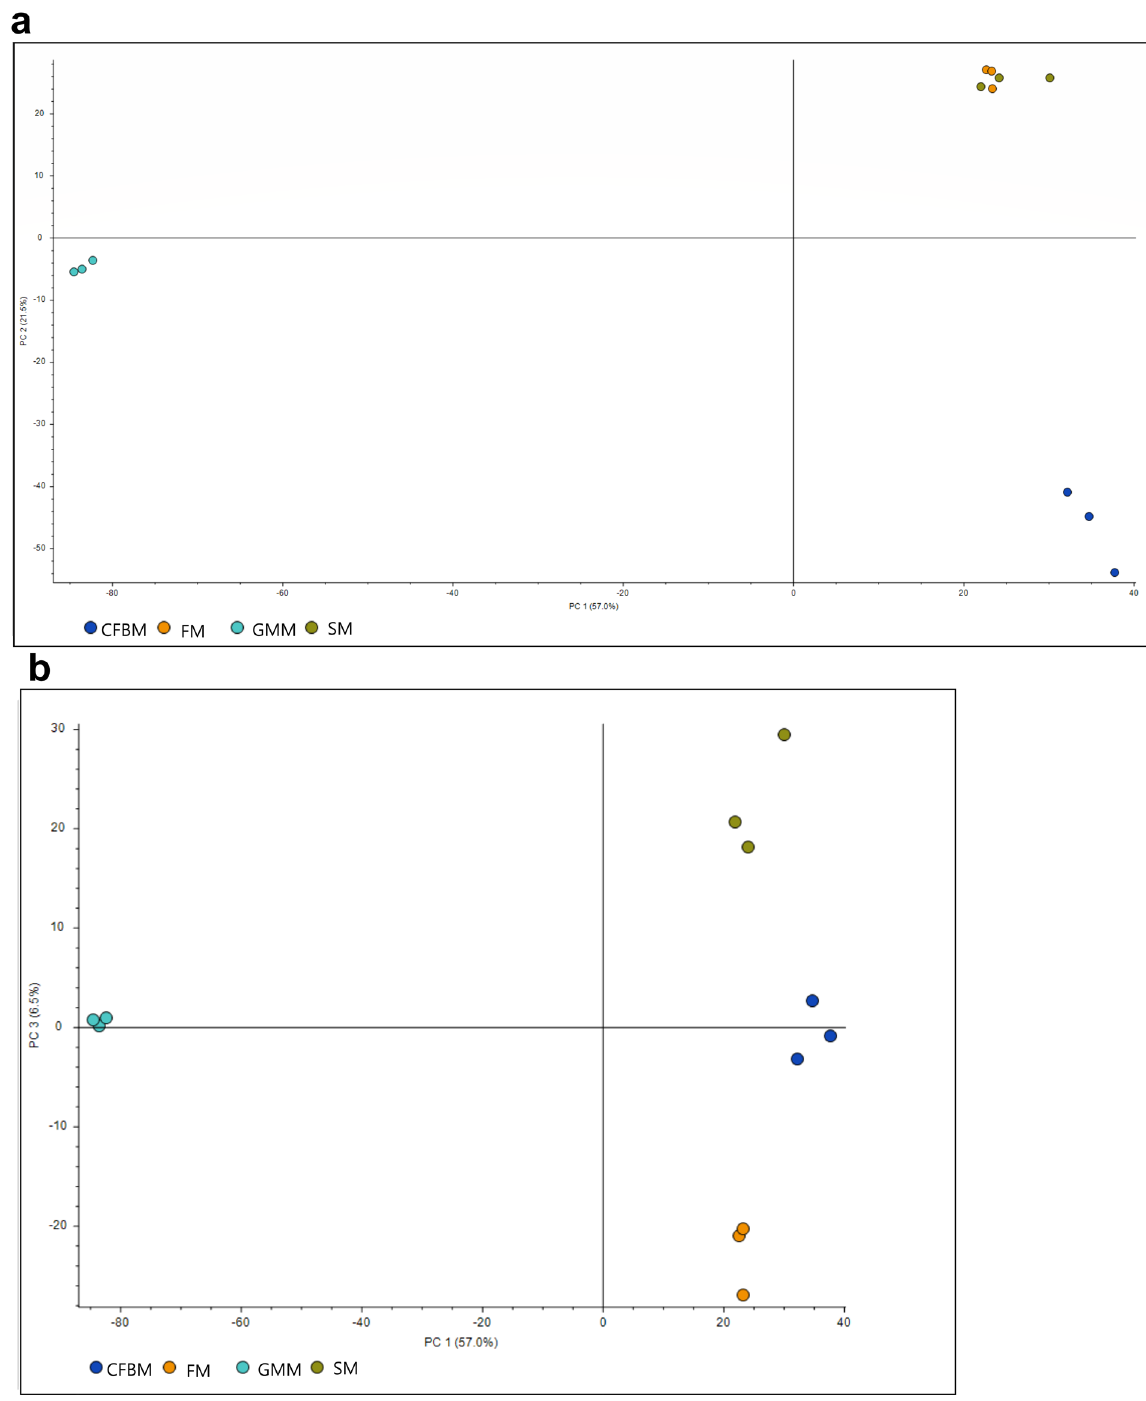
Figure 8. Principal component analysis PC2 vs PC1 ( a ), and PC3 for PCA1 ( b ) showing group and separation of metabolite profiles of GM after 24 h of cultivation in different culture media (SM, GMM, FM,